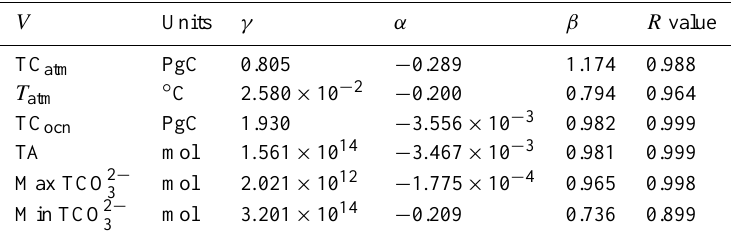
Table 4. Power law scalings for modern configuration, global variables, and (cid:49)V = γD α E β . D in yr and E in PgC.